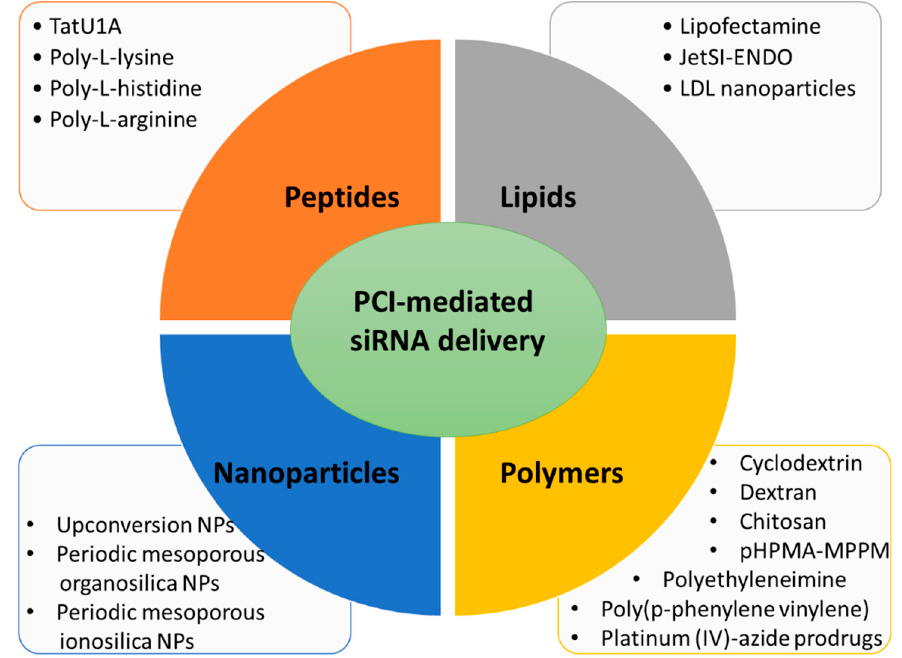
Figure 2. Main types of carriers used for PCI-mediated siRNA delivery discussed in this